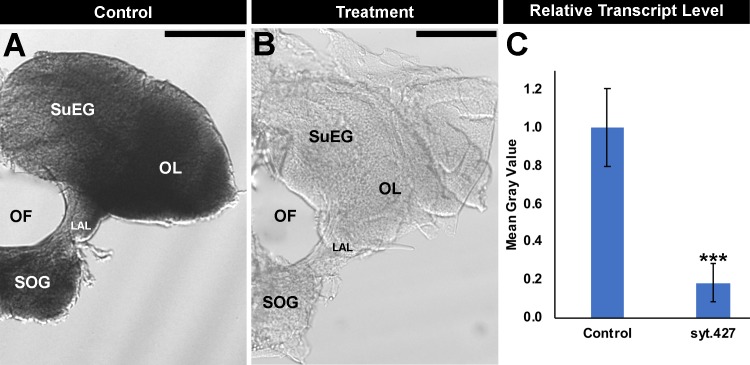
Silencing of Aae syt expression in the larval brain following syt.427 consumption.The high levels of Aae syt expression detected throughout the A. aegypti L4 brain (control-treated larvae shown in A) were significantly reduced in larvae fed with dried inactivated yeast interfering RNA syt.427 tablets (B). Mean gray value results from three biological replicate experiments were compiled (C; n = 60 for syt.427-treated brains; n = 55 for control-treated brains), and these data were evaluated with a paired t-test (C). *** = P<0.001 when compared with control-fed larvae; data are represented as average mean gray values, and error bars denote SEM. Representative brains from these experiments are oriented dorsal upward in this figure. LAL: larval antennal lobe; OF: olfactory foramen; OL: optic lobe; SOG: sub-esophageal ganglion; SuEG: supra-esophageal ganglion. Scale Bar = 100 μm.